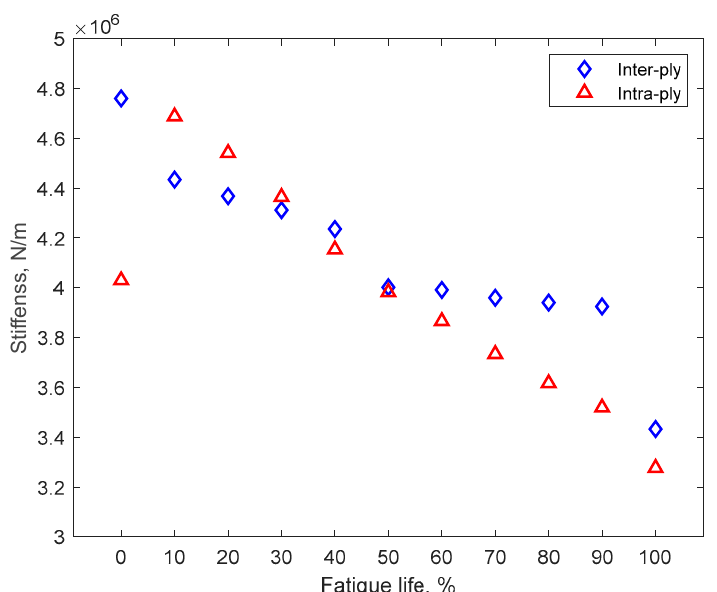
Figure 8. Stiffness distribution for inter-ply and intra-ply hybrid composites over the fatigue life.